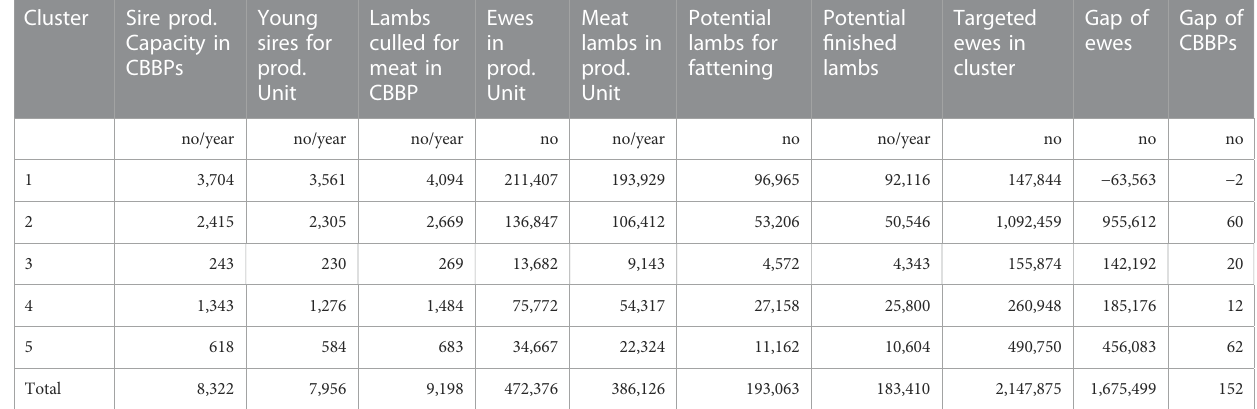
TABLE 2 The effect of CBBPs sire production capacity on production units, meat lamb and potential fattening lamb numbers. Estimated CBBP out-scaling requirements. Cluster Sire prod. Capacity